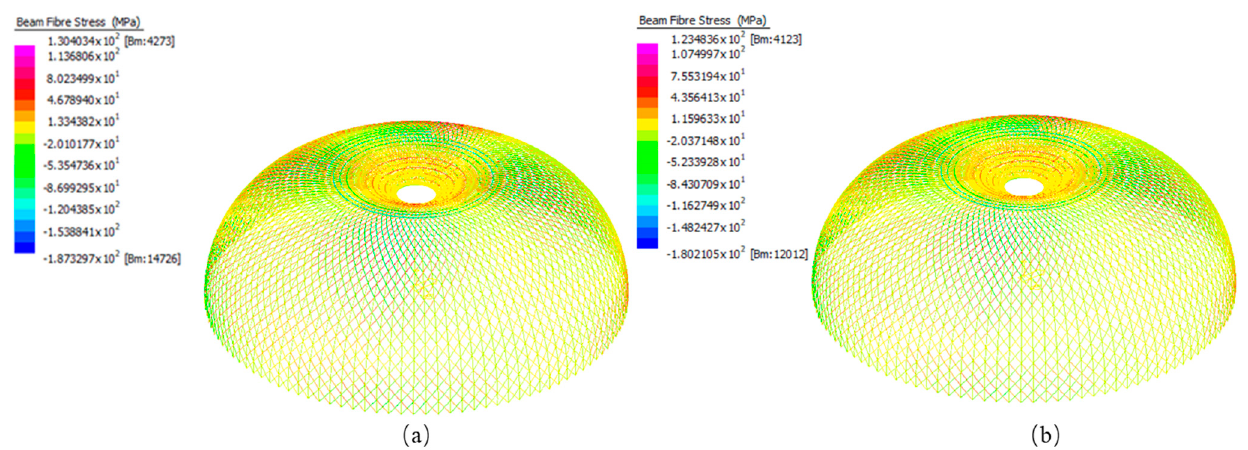
Figure 12. ( a ) Linear analysis of total fiber stress of straight member model under 1.2G + W; ( b ) nonlinear analysis of total fiber stress of straight member model under 1.2G + W.